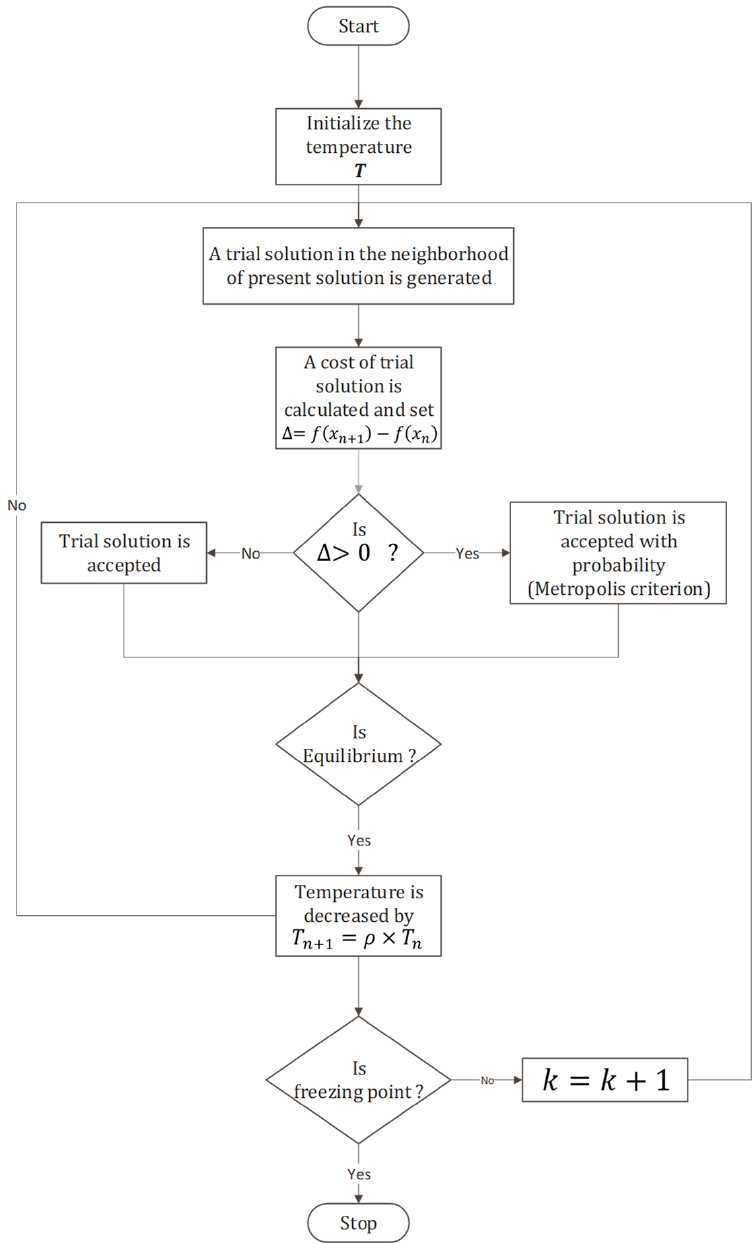
Figure 9. Flowchart representation of the Simulated Annealing method.